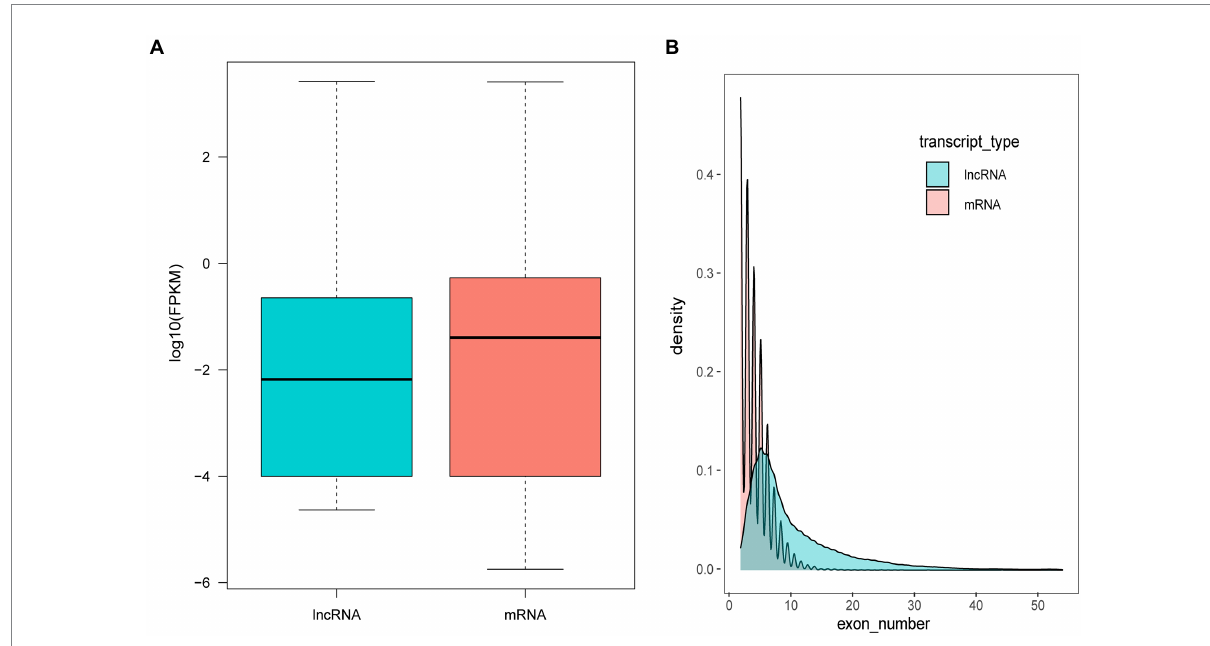
FIGURE 4 Comparison of the expression level (A) and exon number (B) of lncRNAs and protein-coding